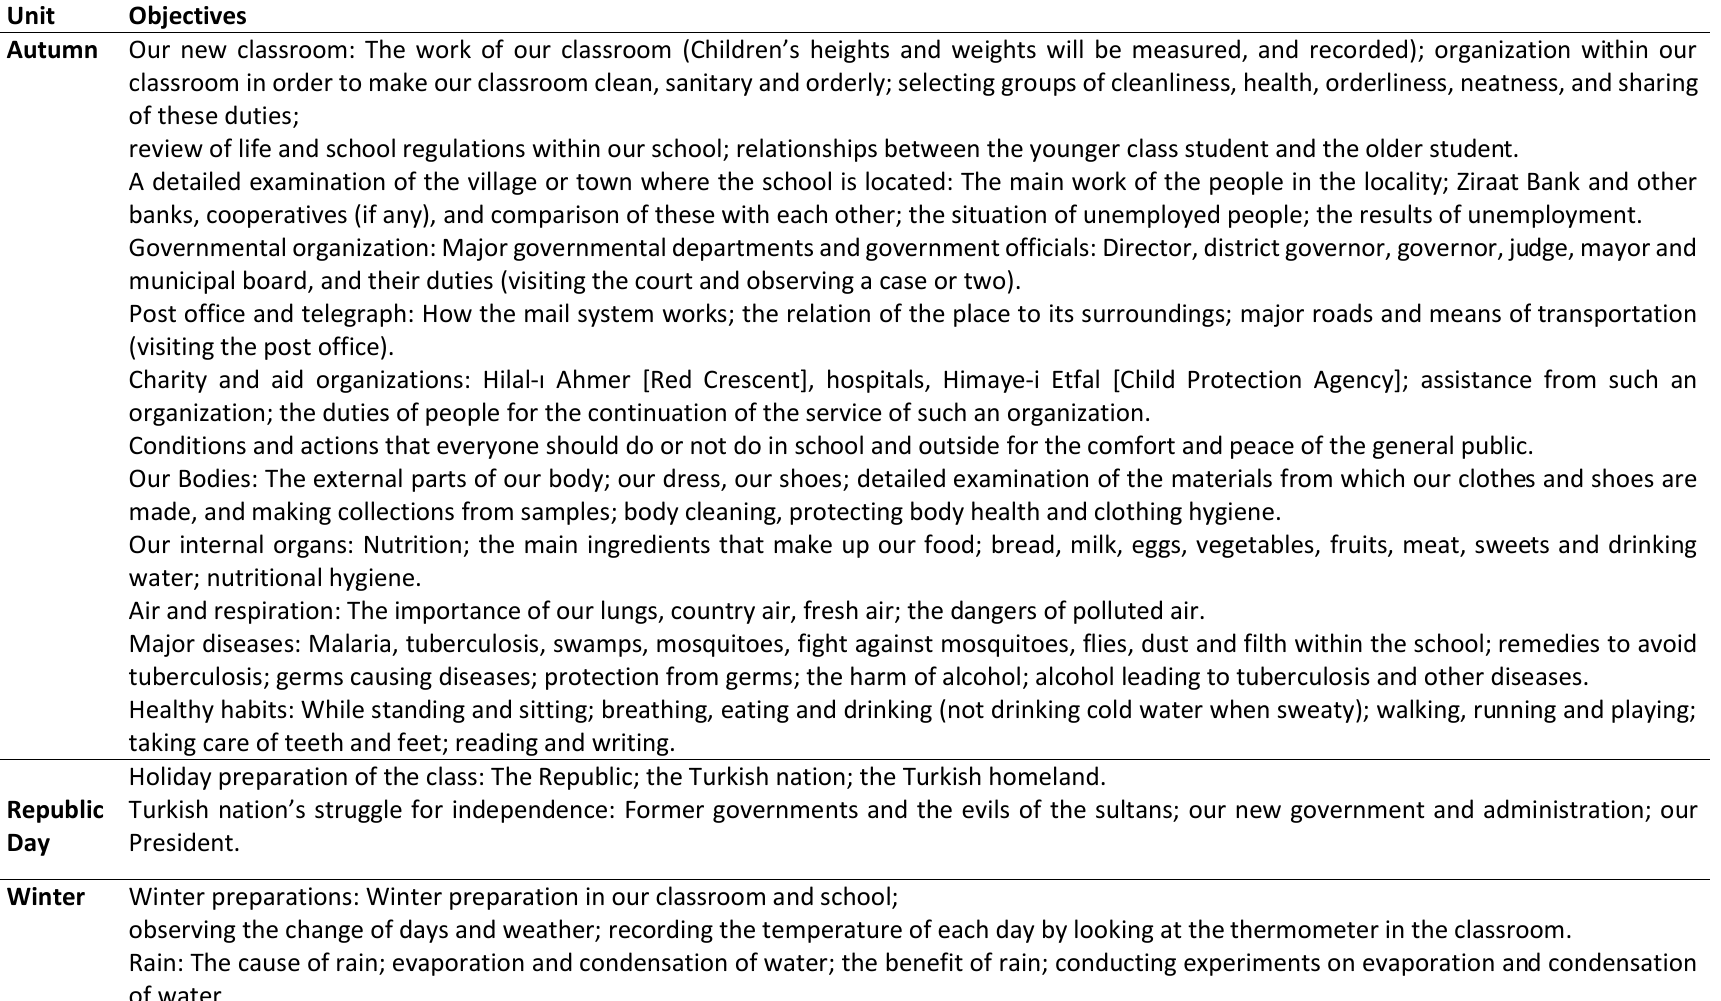
Table 5. Life Studies Curriculum Objectives in the Third Grade